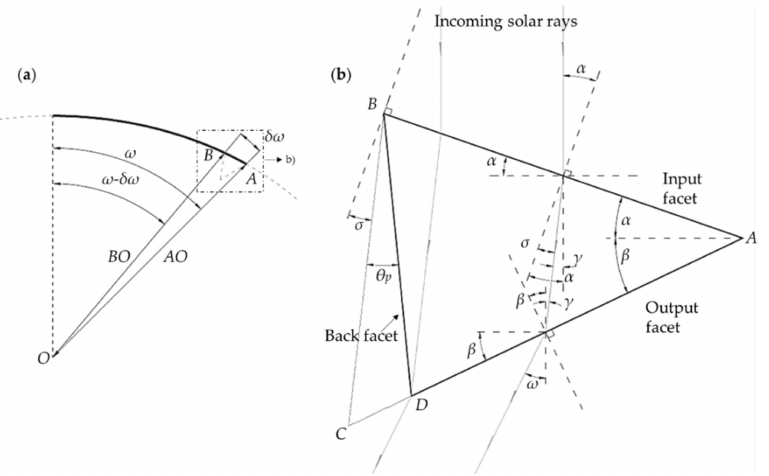
Figure 3. ( a ) Representation of a half-segment of an ESFL. The region defined by point A to B represents the first segment of the ellipse and the input facet of the first prism. The size of the prism is defined by angle δω . The point O represents the origin point and focal zone. AO and BO are the distances between the focal zone with the vertexes A and B of the prism, respectively. ( b ) Detailed visualization of a single prism. The incoming solar rays are refracted by the prism, outputting an angle ω in relation to the normal of its output facet, thus guaranteeing the concentration of light to the focal zone. AB segment is the input facet. Both AC and AD segments represent the output facet, whereas both BC and BD represent the back facet. The pitch angle ( θ p ) defines the unused part of the